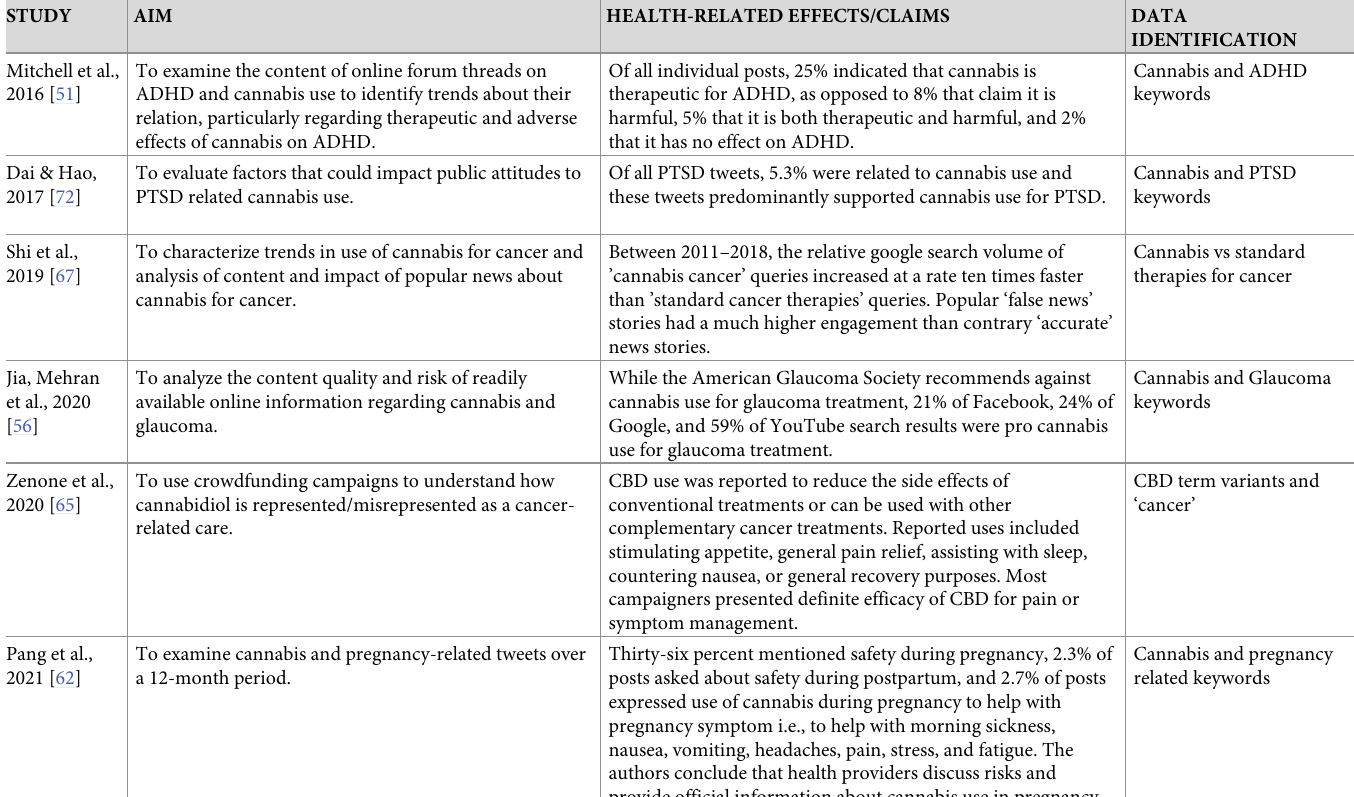
Table 6. Cannabis as a medicine for a specific health